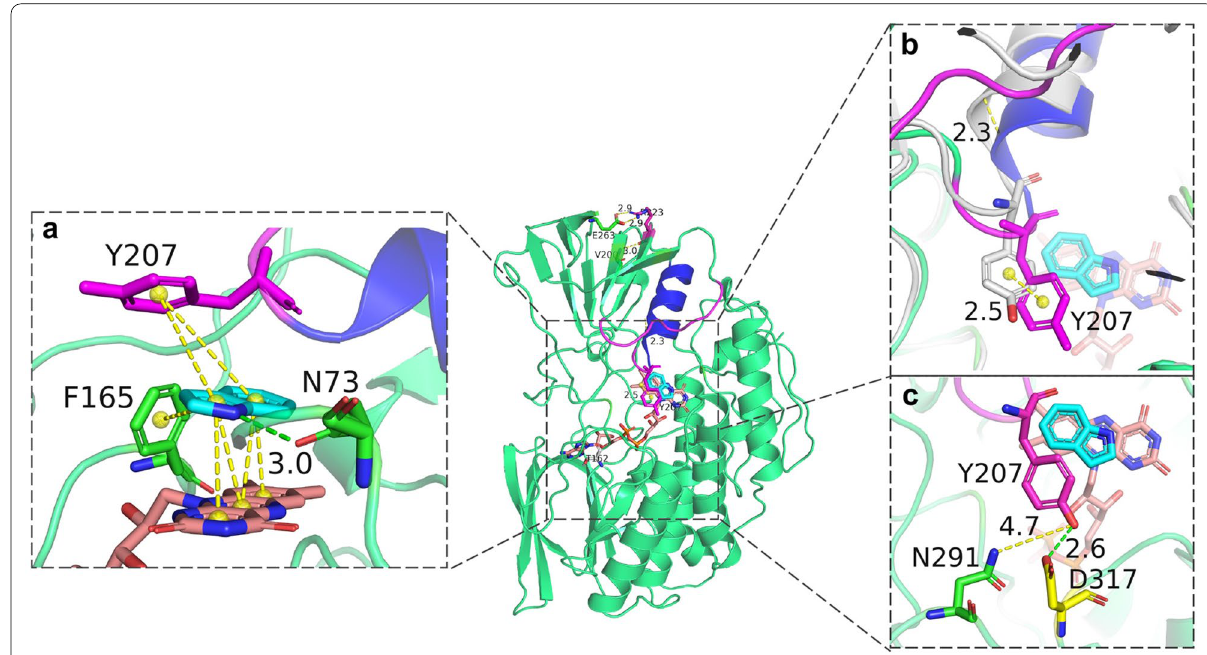
Fig. 6 Structure model of the K223R mutant. a π – π stacking interactions between Y207 (or F165) and indole are indicated by yellow dashed lines. The new hydrogen bond was generated between N73 and indole are presented as green dashed line. b Comparison of the movement of Y207 (shown in yellow sticks) in the K223R mutant (purple) and in the wild‑type bFMO (grey). c Distance between residues of Y207 to N291, and Y207 to D317 are represented as yellow lines and green lines,